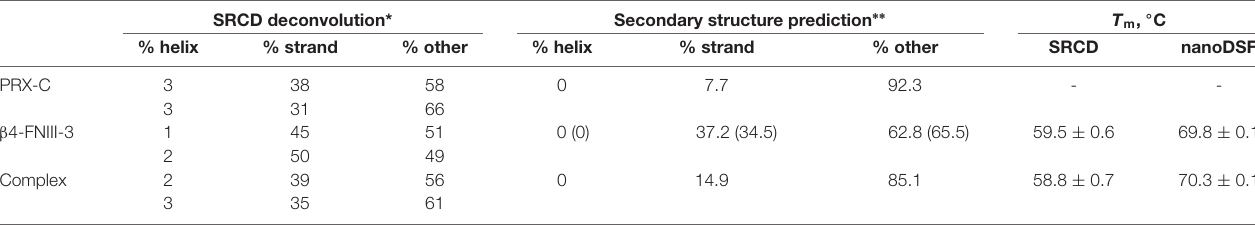
TABLE 2 | Folding and thermal stability of PRX-C and β 4-FNIII-3.